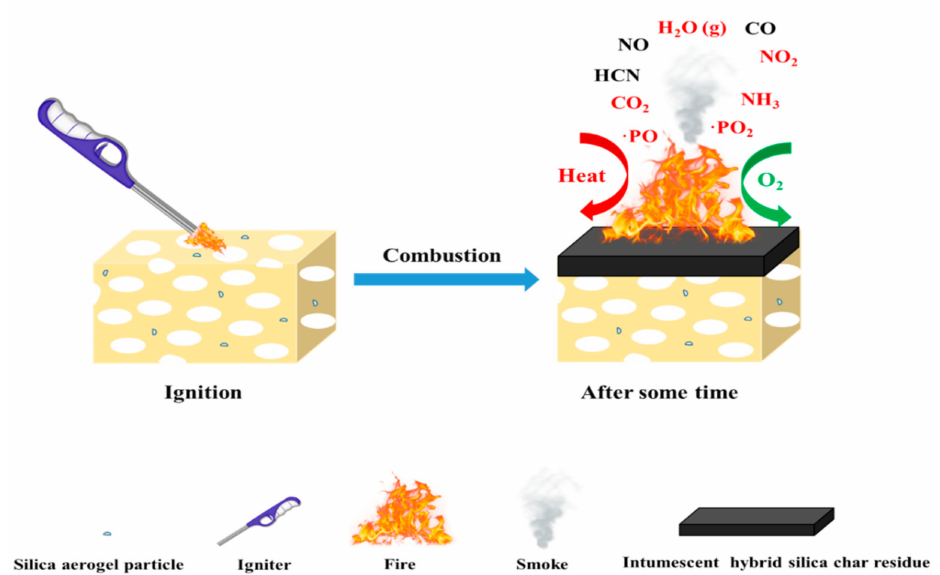
Scheme 3. A possible flame–retardant mechanism for